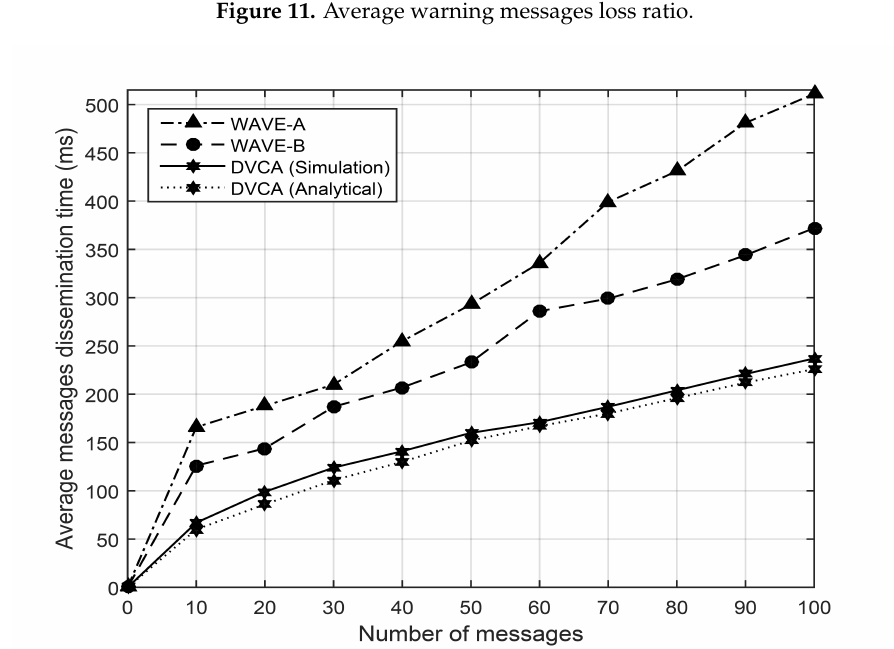
Figure 12. Average warning messages dissemination